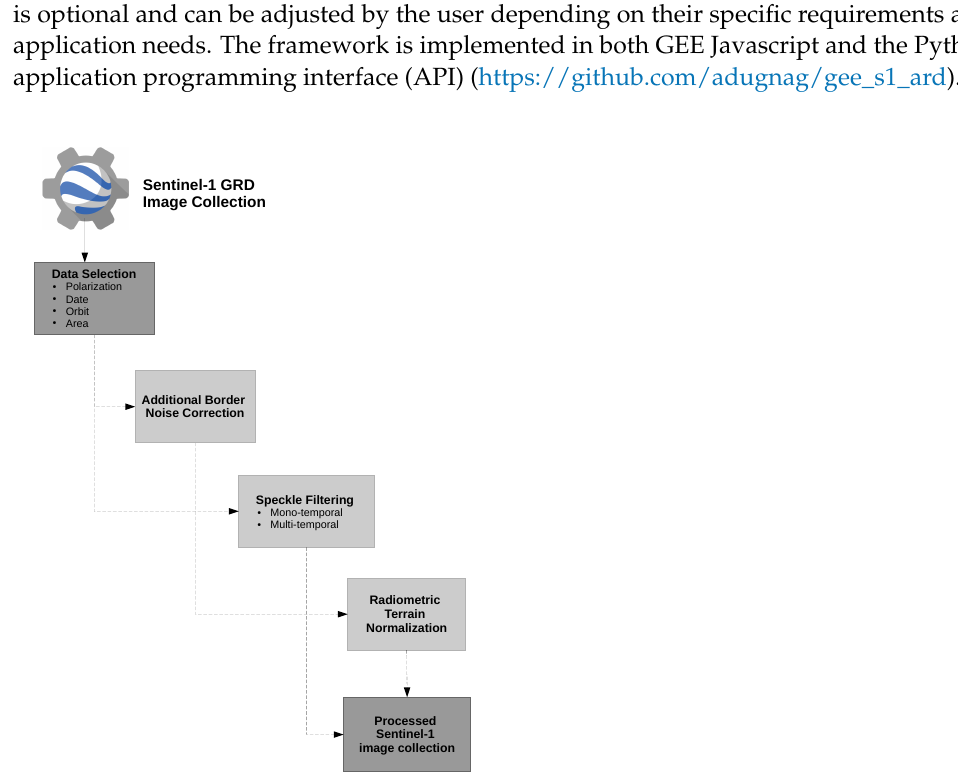
Figure 1. The preparation framework to create Sentinel-1 ARD in GEE. The dark grey box depicts the mandatory steps and the light grey ones depict the optional preprocessing